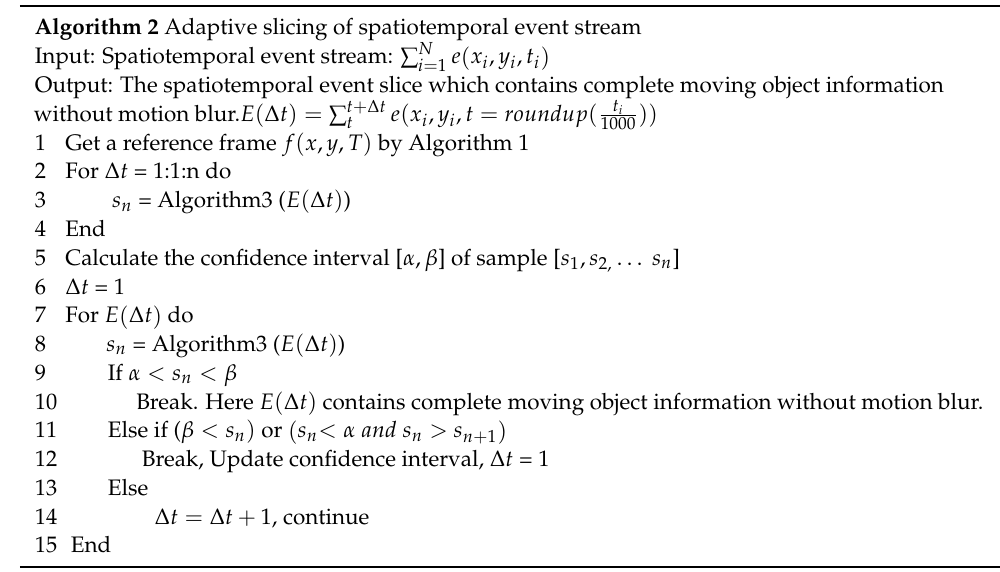
Algorithm 2 Adaptive slicing of spatiotemporal event stream